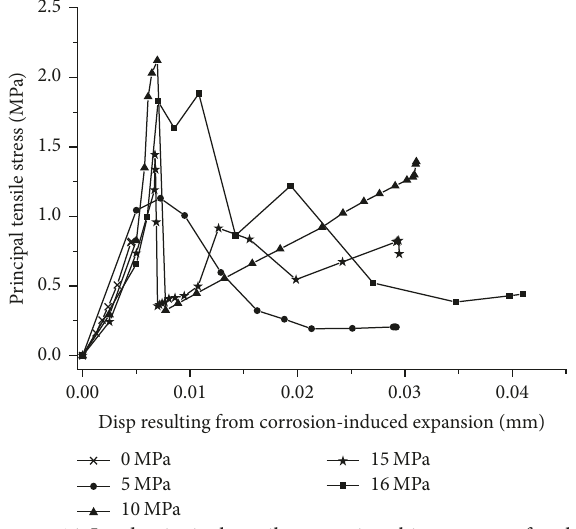
Figure 16: Load-principal tensile stress time-history curve for ele- ment 2.